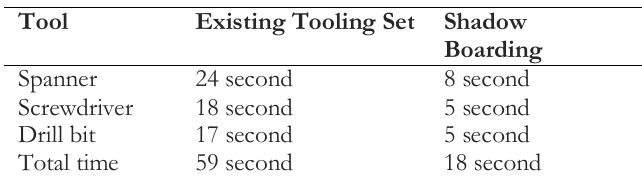
Table 3. A comparison of requirement of searching time of tool in existing tooling set and shadow boarding.